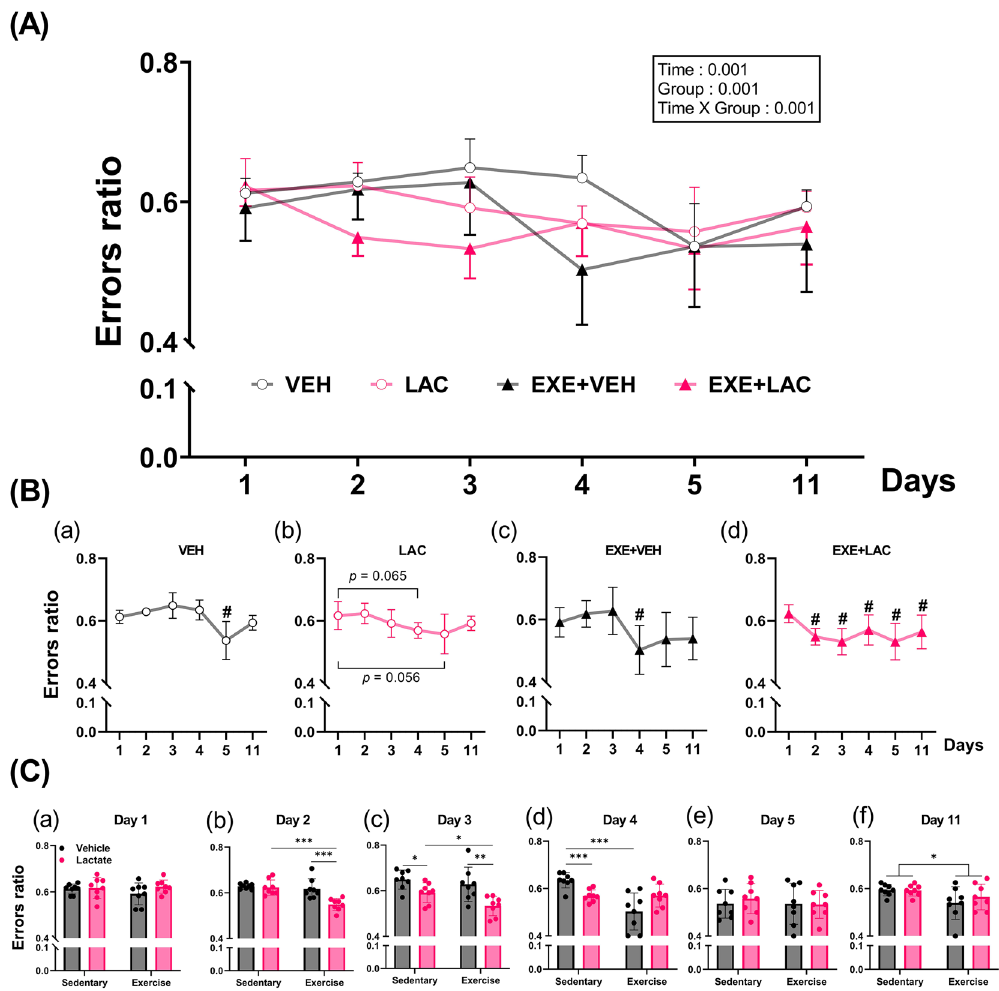
Figure 4. Exercise with lactate administration augmented exercise-induced improvement in reference and retention memory. The test was conducted using eight-arm radial arm maze (RAM). Day 1 to 5 is learning phase of RAM task and Day 11 is retention memory trial of RAM task. ( A ) The entire results of RAM task. Two-way repeated ANOVA was performed. In order to improve readability of indications of post hoc results, ( B ) the results of comparison of changes over time within the same group (paired t -test was used for post hoc test) and ( C ) the results of comparison of difference among groups within the same day (independent Student’s t -test was used for post hoc test) are separately presented. VEH sedentary without lactate, LAC sedentary with lactate, EXE + VEH exercise without lactate, EXE + LAC exercise with lactate; n = 8 per group, * p < 0.05, ** p < 0.01, and *** p ≤ 0.005; # p < 0.05, vs day 1 within group. Data are presented as the mean ± standard